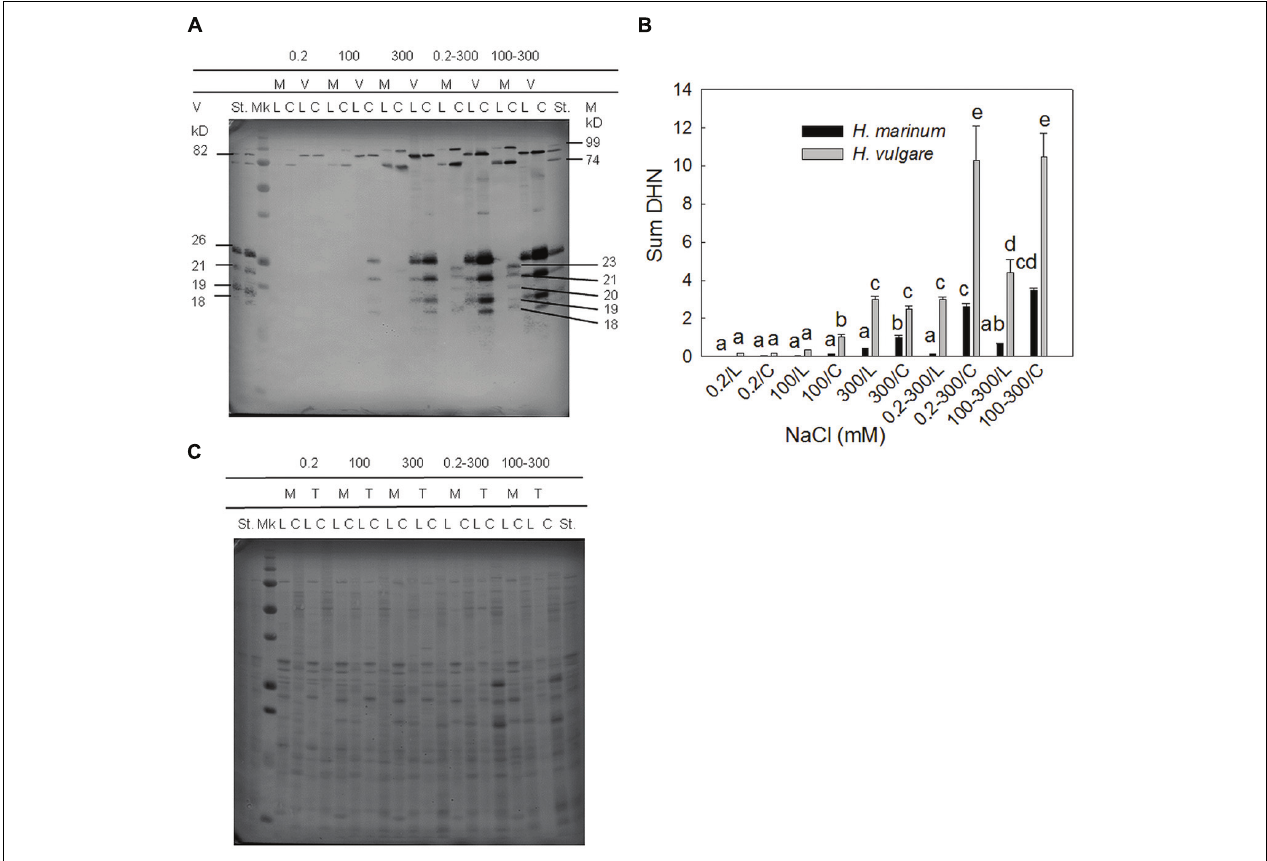
FIGURE 2 | A representative immunoblot (A) and a graph showing the results of densitometric analysis of dehydrin protein relative accumulation (sum of all dehydrin bands detected in a given sample; B). M- H. marinum (black columns), V- H. vulgare cv. Tadmor (gray columns). C, crown; L, leaf; Mk, protein marker All Blue Precision Plus Protein Marker Standard (Bio-Rad), St - internal standard (a mixed sample containing equal amounts of all samples used in the experiment and loaded on each gel). (B) Dehydrin protein relative abundance in the individual samples was expressed as fold changes with respect to the internal standard St. Different letters above the columns indicate significant differences between the variants determined by ANOVA, multiple comparisons, Duncan’s multiple range test at 0.05 level. (C) Proteins transblotted onto nitrocellulose membrane were visualized by staining with Ponceau S (Sigma–Aldrich).